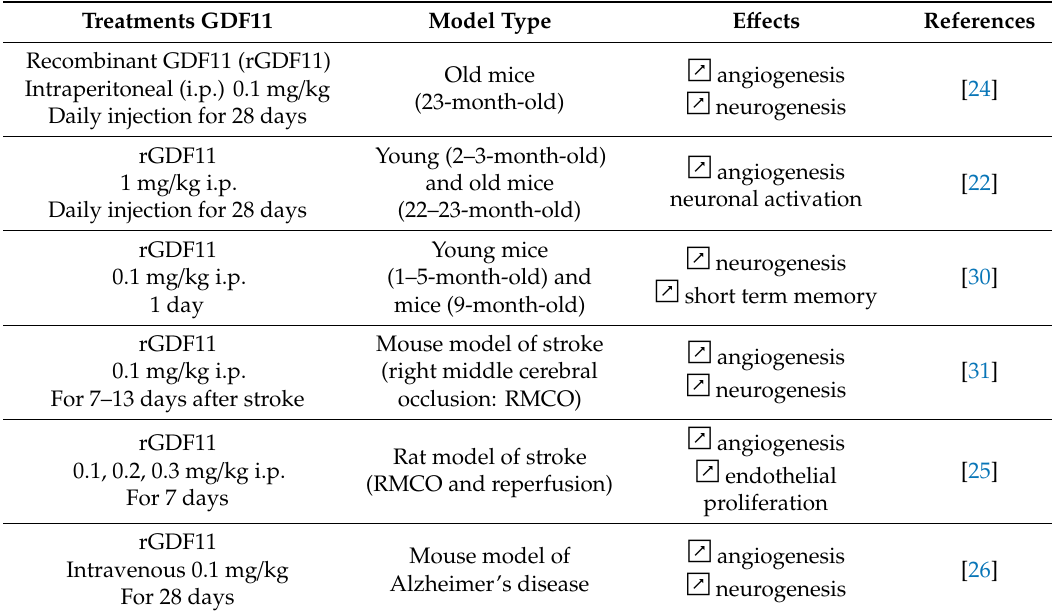
Table 1. Pro-angiogenic and pro-neurogenic properties of GDF11 in aging and disease models.